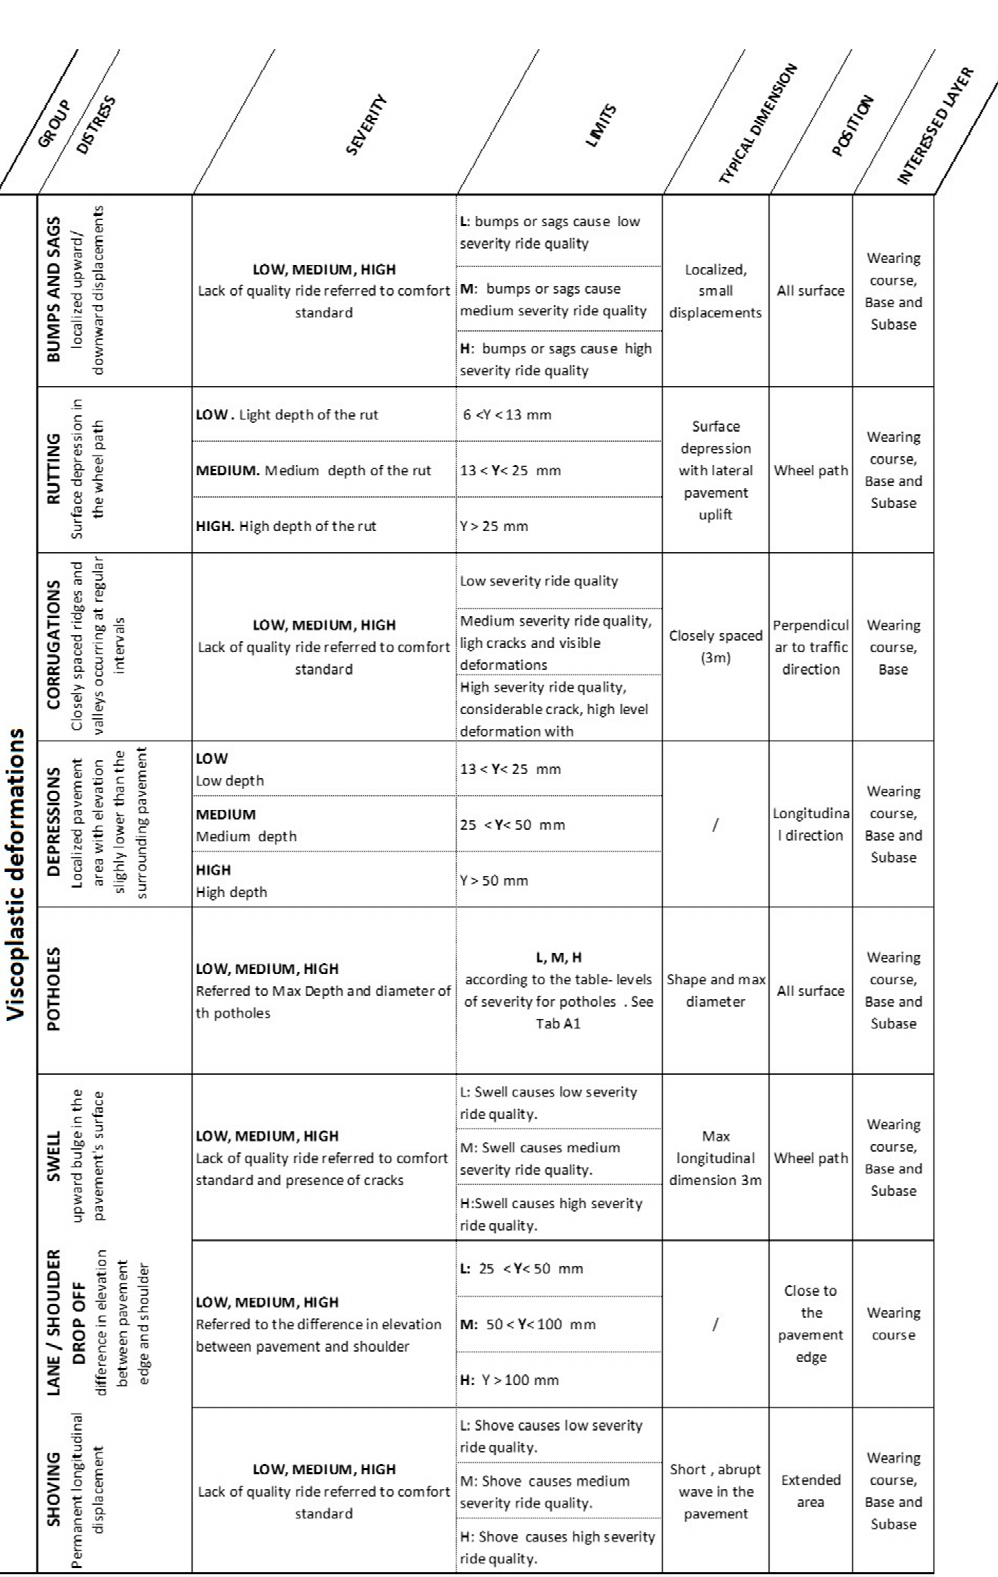
Figure A2. Viscoplastic deformation Group.